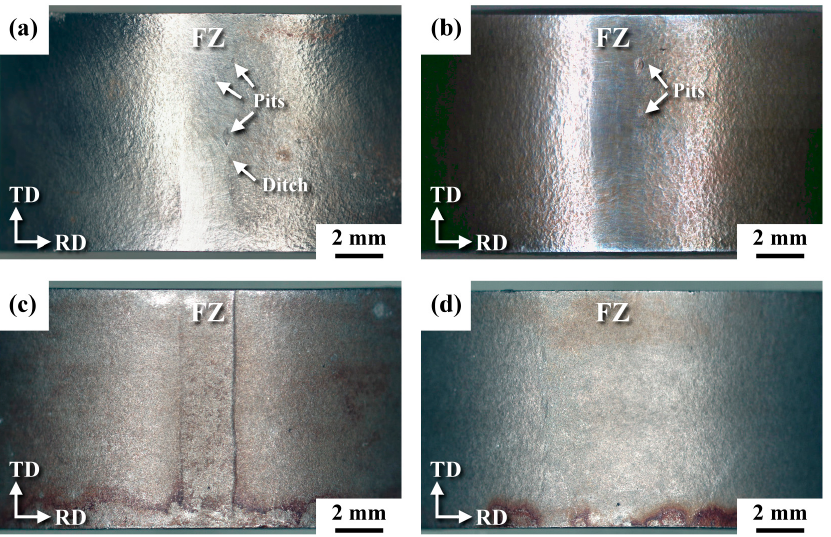
Figure 11. The typical surface morphologies of the U-bend samples after salt spray. ( a ) 304 weld, ( b ) 316 weld, ( c ) micro-shot peened 304 weld and ( d ) micro-shot peened 316 weld.